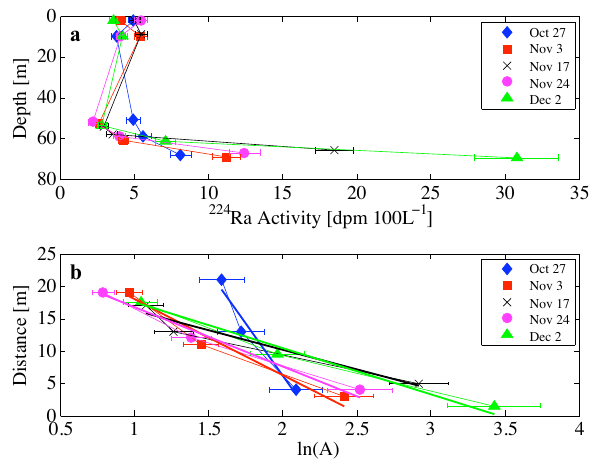
Fig. 5. (a) Vertical profiles of 224 Radium. Black dashed box indi- cates deep-water samples used in the 1-D diffusive model. (b) Nat- ural logarithm (ln) transformations of 224 Ra activity plotted as a function of distance from the sediment surface (dotted line). Each daily set of points is fit with a least-squares regression used to esti- mate mixing rates ( K Z ) and interface activities ( A 0 ). The different characteristics of the 26 October plot relative to all other days rep- resents the different mixing regime during this